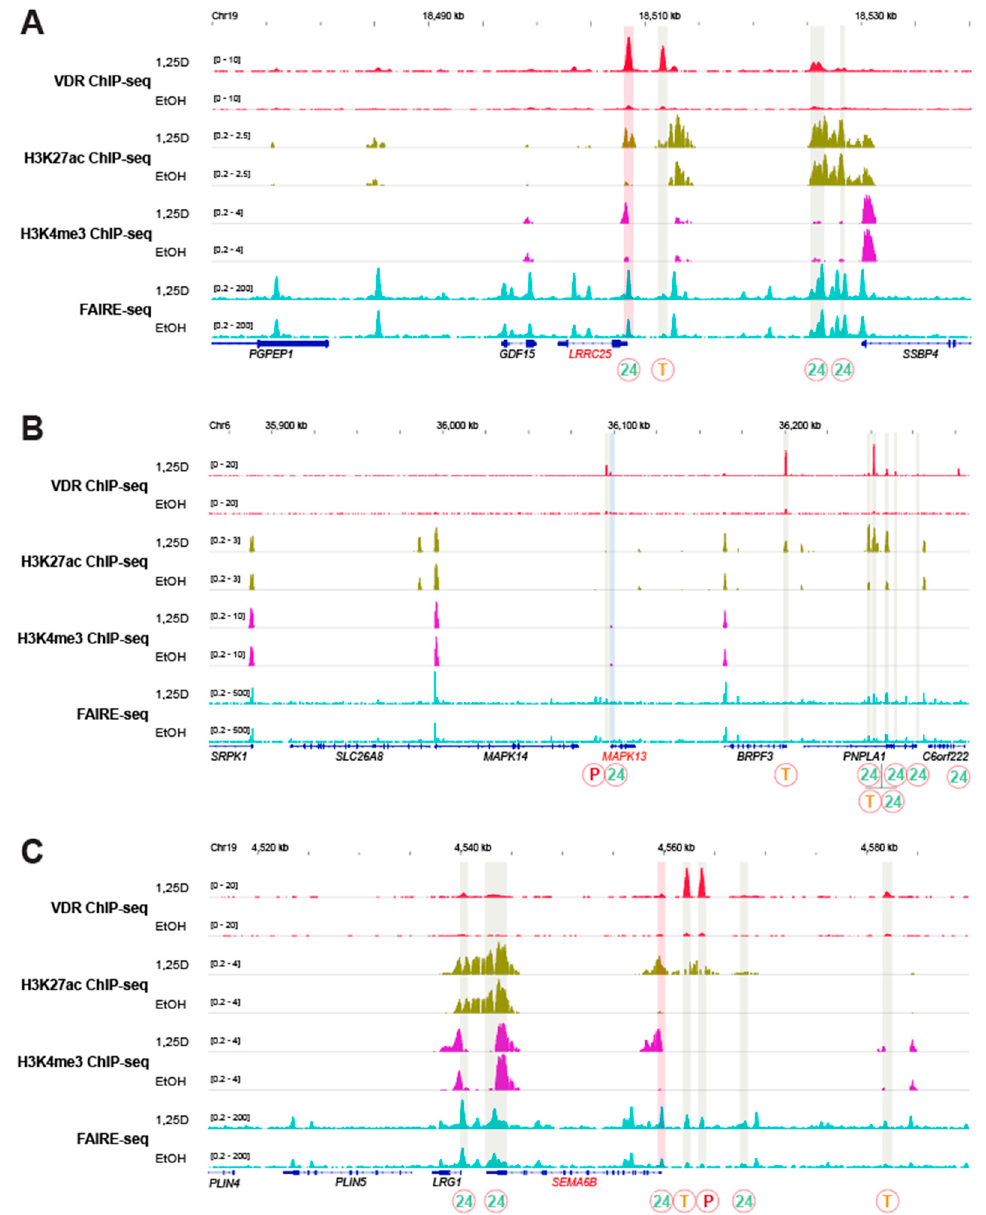
Figure A3. Vitamin D target genes controlled by non-ligand-dependent single enhancers. The IGV browser was used to visualize VDR ChIP-seq results (red) obtained in THP-1 cells that had been treated for 24 h with 1,25(OH) 2 D 3 (1,25D) or solvent (EtOH) [28]. VDR-bound enhancers are shaded in grey, ligand-dependent TSS regions in red and non-ligand-dependent TSS regions in blue. The type of VDR binding sites at enhancers is indicated as persistent (P), transient (T) and 24 h only (24) [28]. These data are compared with ChIP-seq results obtained under the same conditions for histone markers of active chromatin (H3K27ac, green) [35] and active TSS regions (H3K4me3, purple) [35] as well as with FAIRE-seq data (turquoise) [29]. The peak tracks display merged data from the three biological repeats. Gene structures are shown in blue and the vitamin D target genes LRRC25 ( A ), MAPK13 ( B ) and SEMA6B ( C ) are highlighted in red. The genomic regions 1 Mb up- and downstream of the gene’s TSS were inspected but only the areas relevant for 1,25(OH) 2 D 3 -dependent regulation are displayed.